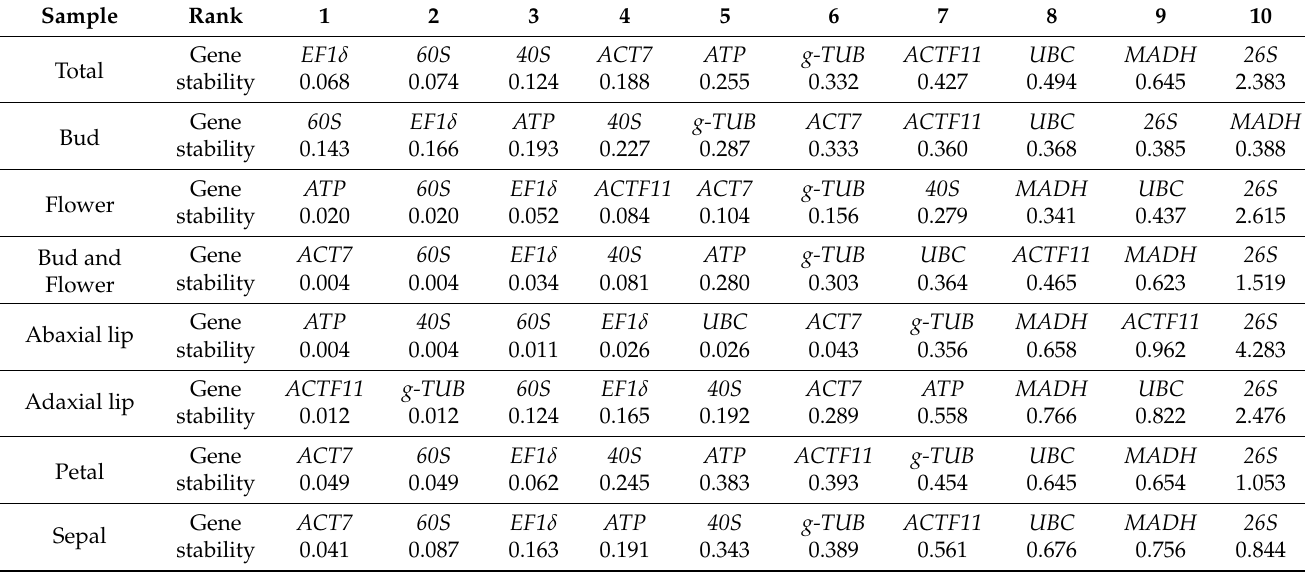
Table 2. Expression stability of the nine candidate reference genes as calculated by